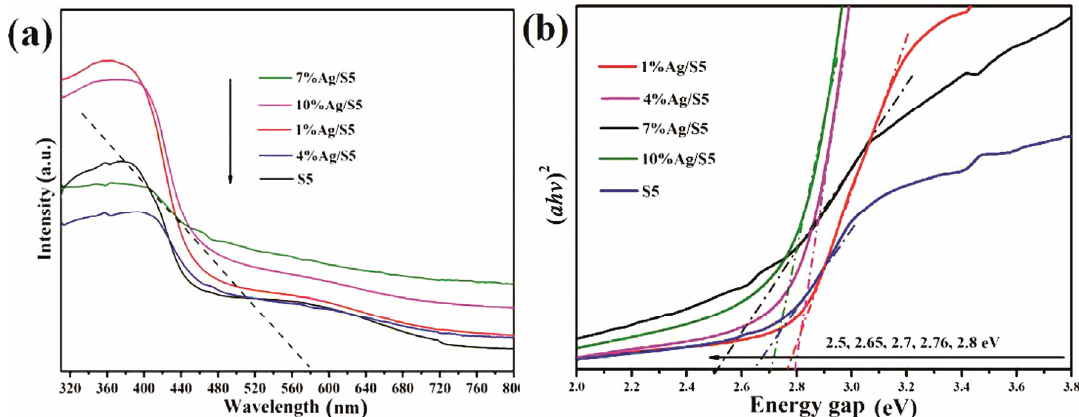
Fig. 4 (a) UV–Vis absorption spectra of the ternary samples and (b) the band gap of all